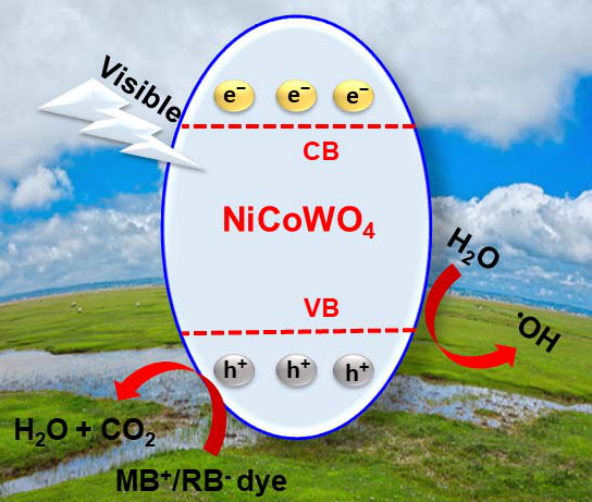
Figure 9. Schematic representation of dye degradation by calcined Ni-CoWO 4 NPs.